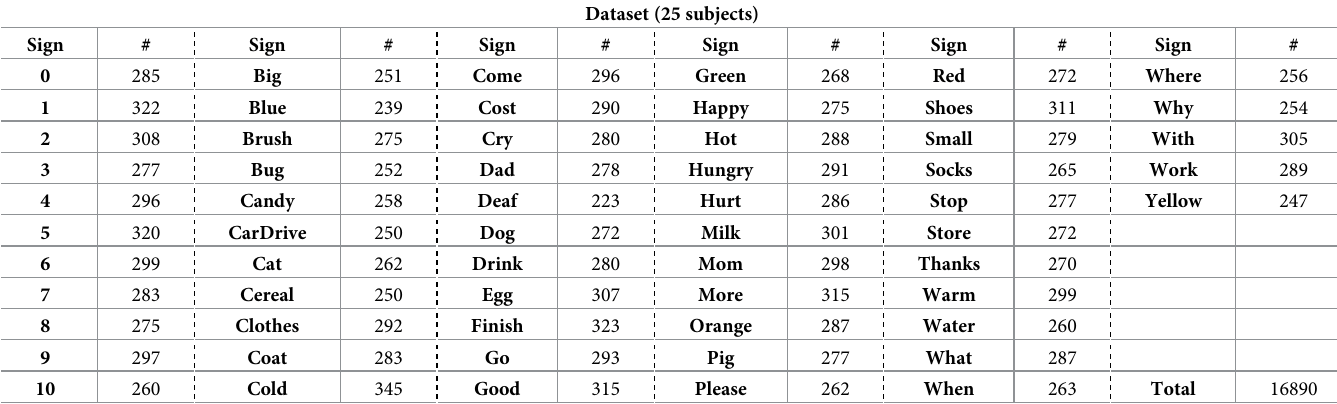
Table 1. Numbers of sign gathered during the experiment with the 25